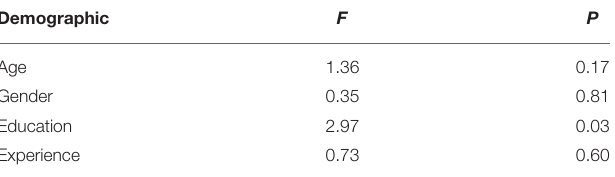
TABLE 2 | One-way ANOVA.